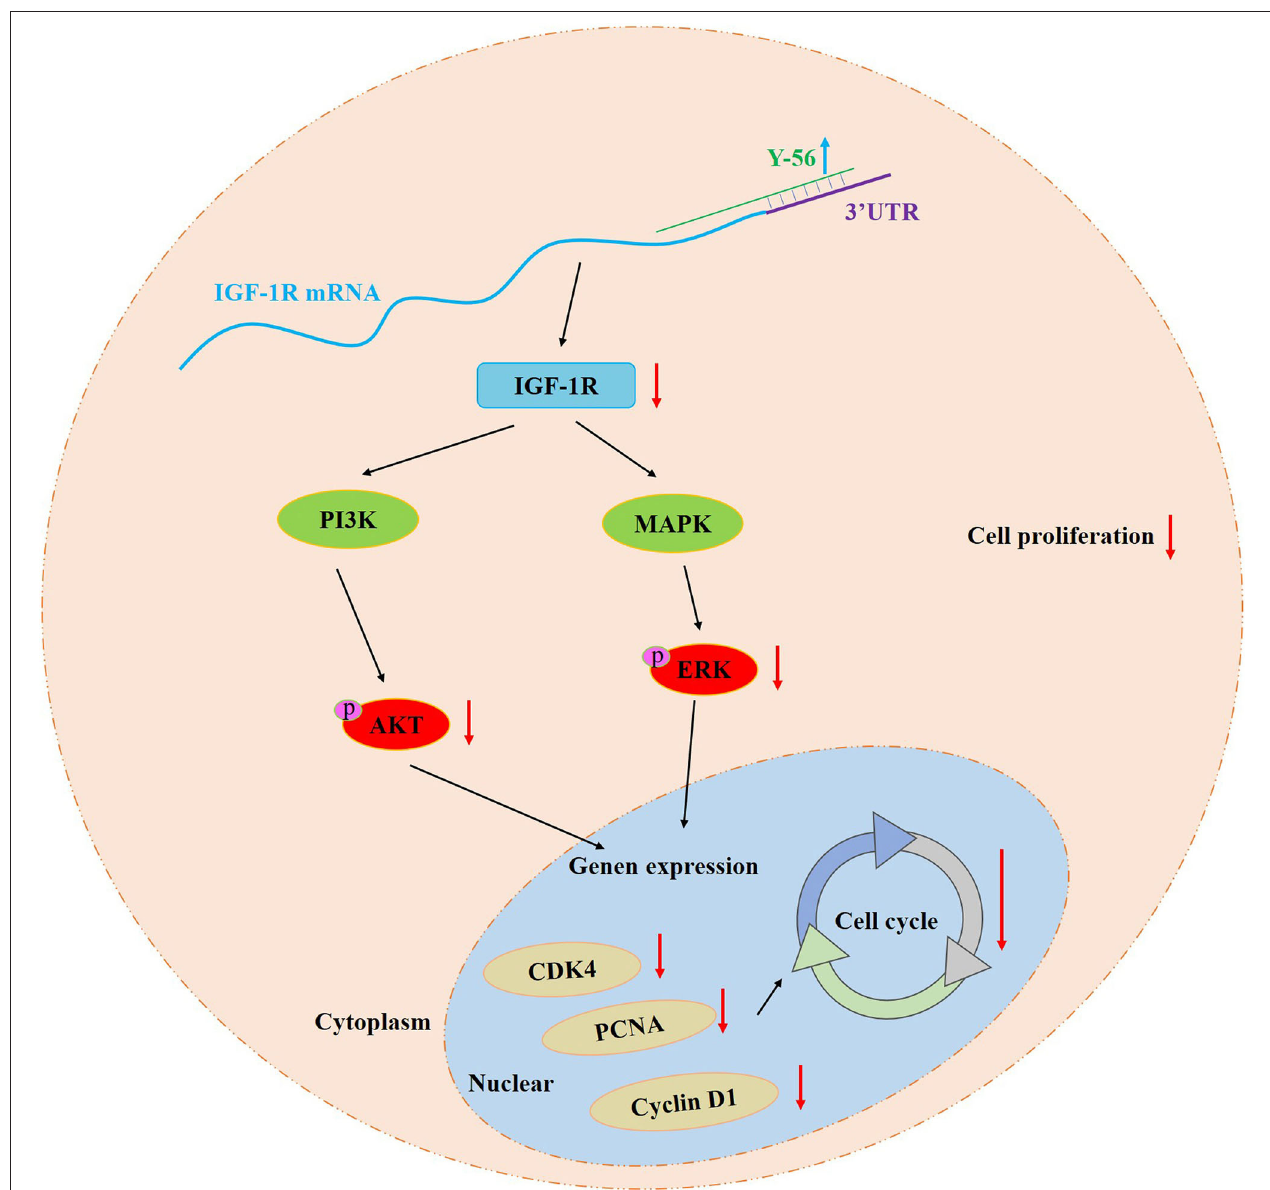
FIGURE 9 | Schematic model of Y-56 regulation on the PSCs